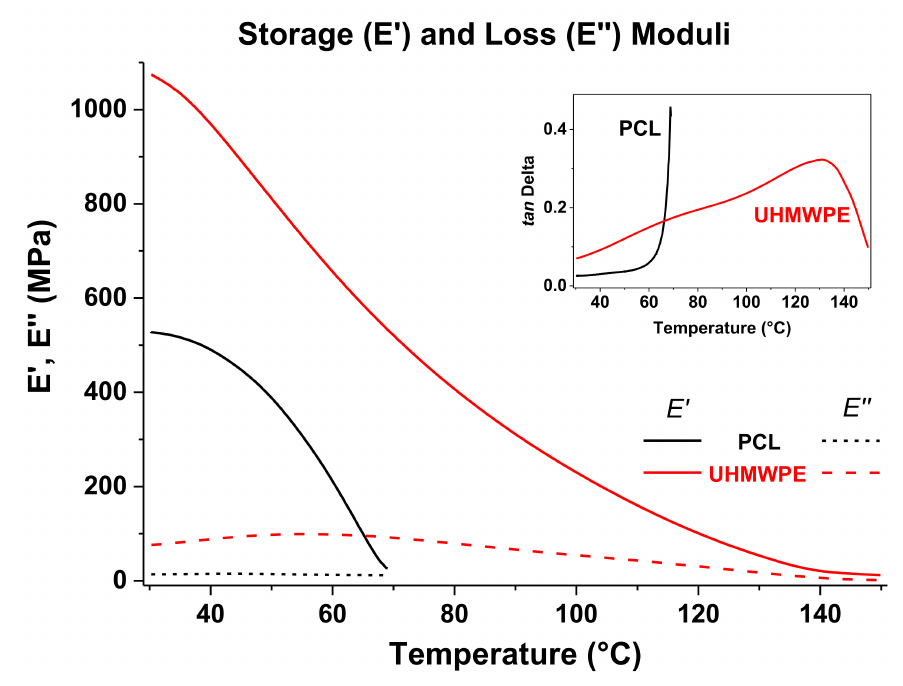
Figure 7. Storage and loss moduli from DMA for PCL and UHMWPE. The inset graph corresponds to the plots of tan δ .